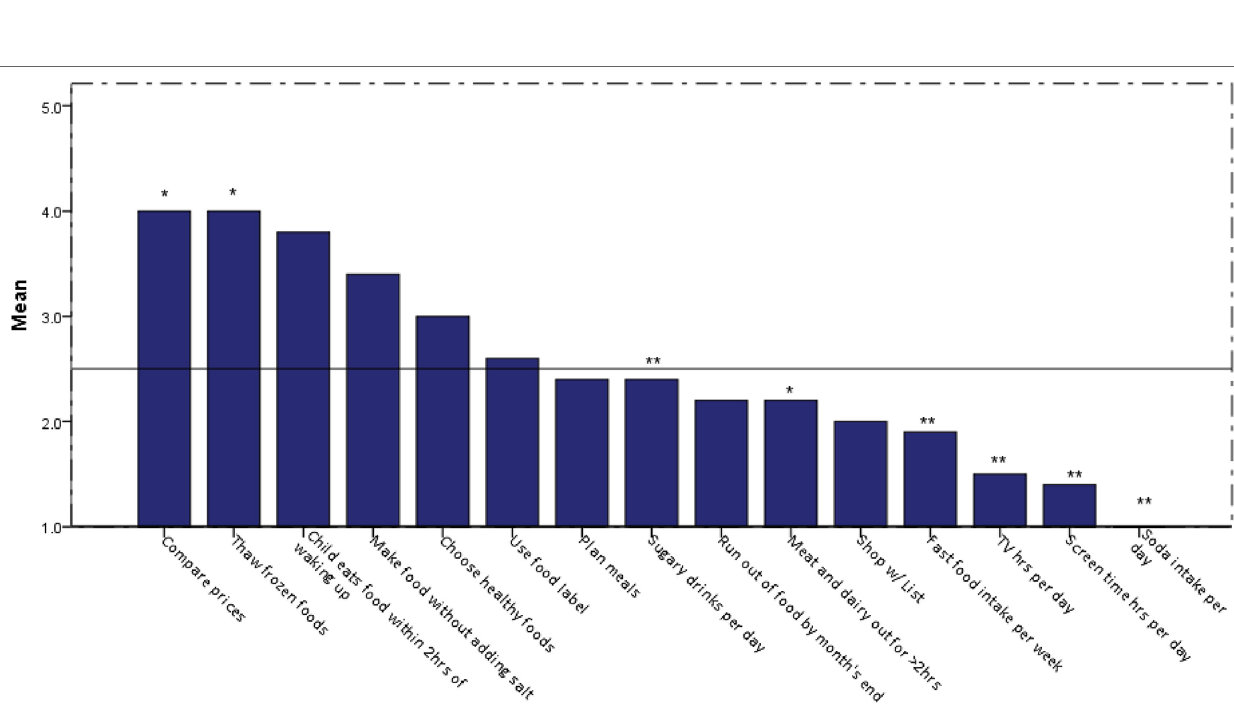
FigUre 2 | Eating behaviors of shape-up and eat right-families prior to intervention. Legend: 1 = no, 2 = sometimes, 3 = often, 4 = very often, 5 = almost always; **Frequency on Y -axis corresponds to number variable; * p <